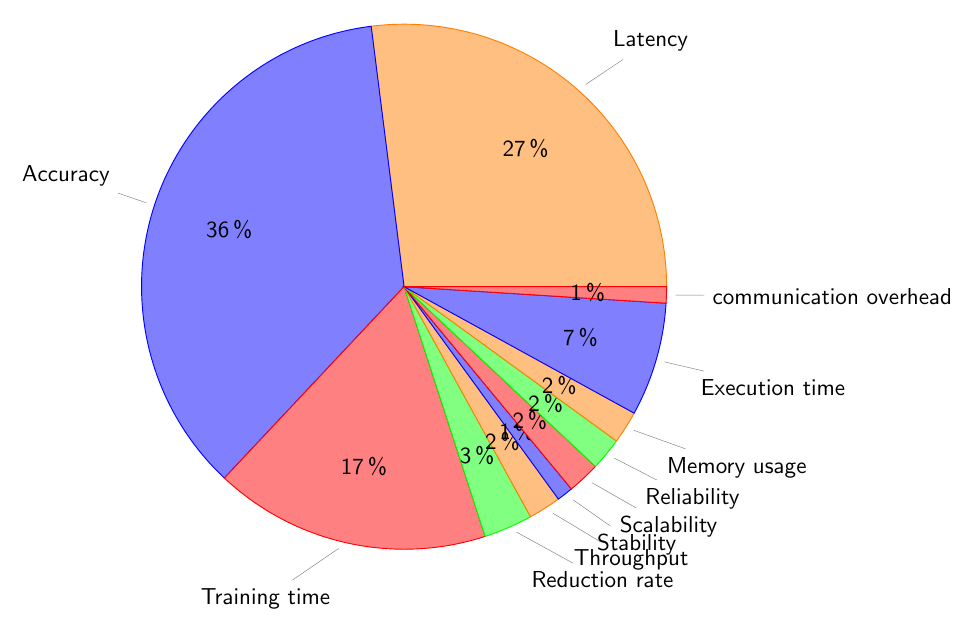
Figure 8. Performance